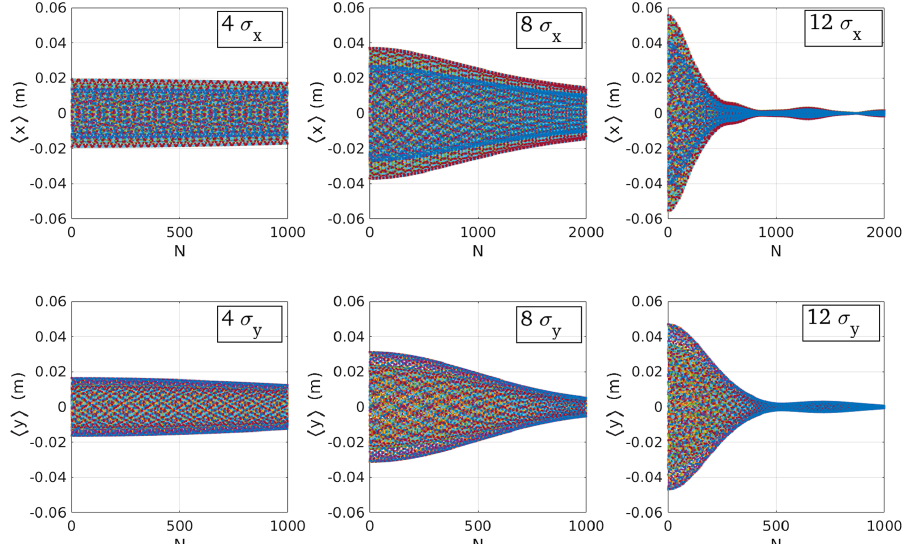
FIG. 8. The turn-by-turn response of the centroid of the beam, for different kick strengths. The top row depicts the horizontal oscillation and the bottom row the vertical. The left column shows the TBT data for an initial amplitude of 4 σ , the middle column for 8 σ , and the right column for 12 σ .